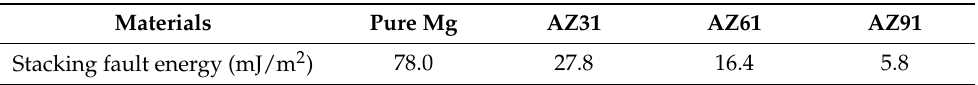
Table 3. Stacking fault energies of pure magnesium and its alloys (calculated) [30].